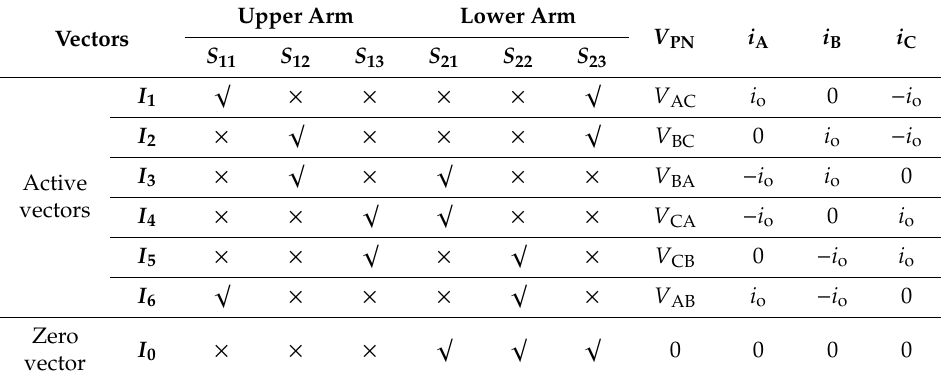
Table 1. The switching states corresponding to the space vectors of the proposed CSR.